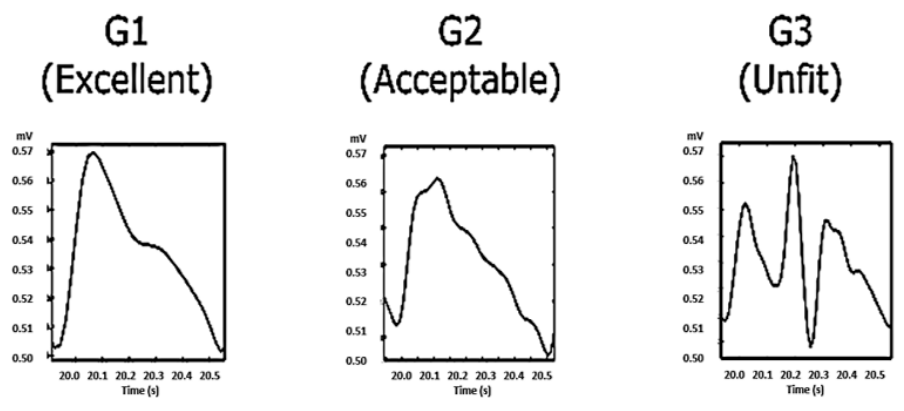
Figure 5 . Skewness characteristics. Figure 5. Skewness